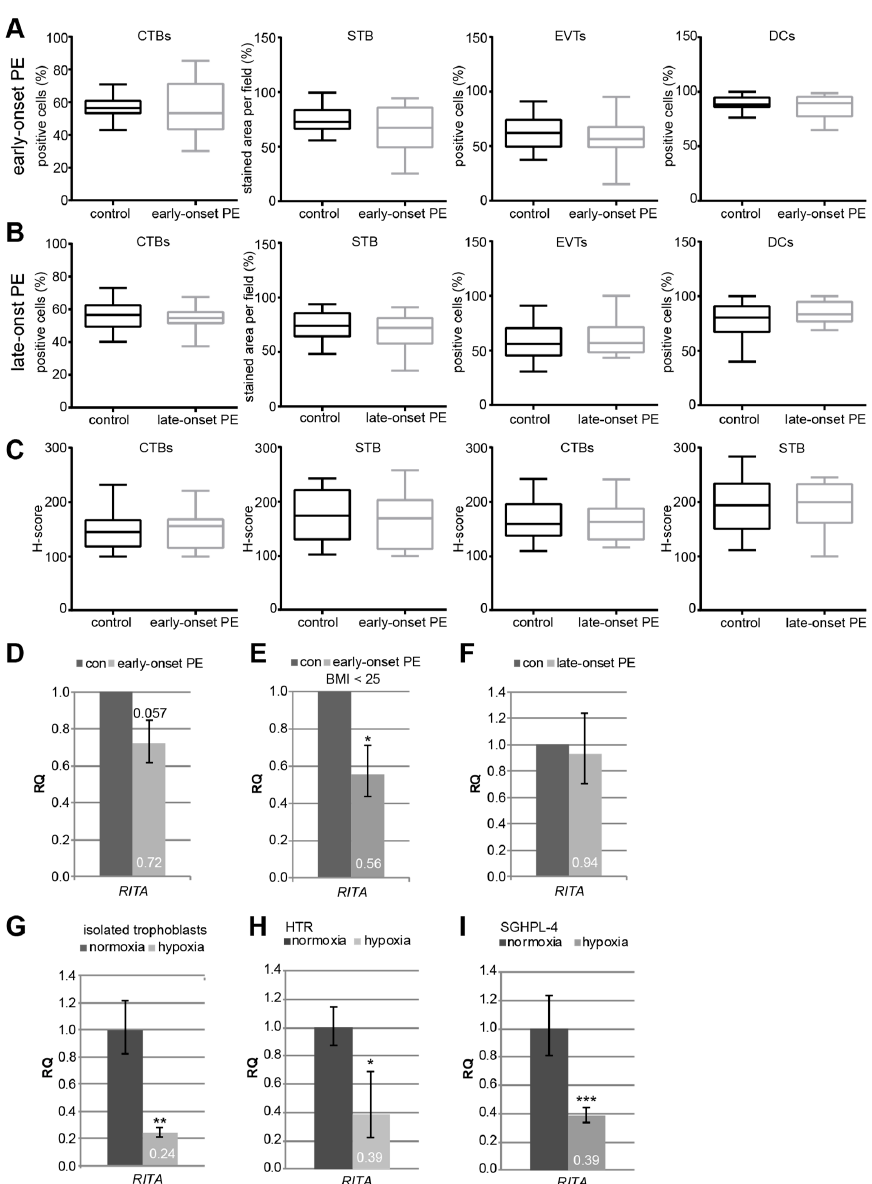
Figure 2. RITA ’s gene expression is decreased in early-onset preeclampsia (PE) samples, in isolated primary trophoblasts and first trimester-derived cell lines under hypoxic conditions. ( A – B ) Immunohistochemical staining of RITA in placental sections was analyzed. Comparison of RITA-positive cells between early-onset PE (25–33 weeks, n = 15) and matched controls (24–33 weeks, n = 16) ( A ), and between late-onset PE (34–40 weeks, n = 14) and matched controls (34–40 weeks, n = 19) ( B ). The results are presented as box and whisker plots with minimum and maximum variations. ( C ) Quantification of RITA in CTBs and STB using the H-score method. The results are presented as box and whisker plots with minimum and maximum variations. Clinical information is listed in Table 1. ( D – I ) Gene analysis. ( D ) The relative amount of the gene RITA was determined in early-onset PE (25– 33 weeks, n = 14) compared to matched control samples (26–33 weeks, n = 13). Student’s t -test, p = 0.057. ( E ) The relative amount of RITA is significantly reduced in placentas derived from patients with a body mass index (BMI) below 25 ( n = 8) relative to controls ( n = 6). Student’s t -test, * p < 0.05. ( F ) The relative amount of placental RITA in late-onset PE (34–40 weeks, n = 15) compared to the matched controls (34–40 weeks, n = 18). The results are presented as relative quantification (RQ) with minimum